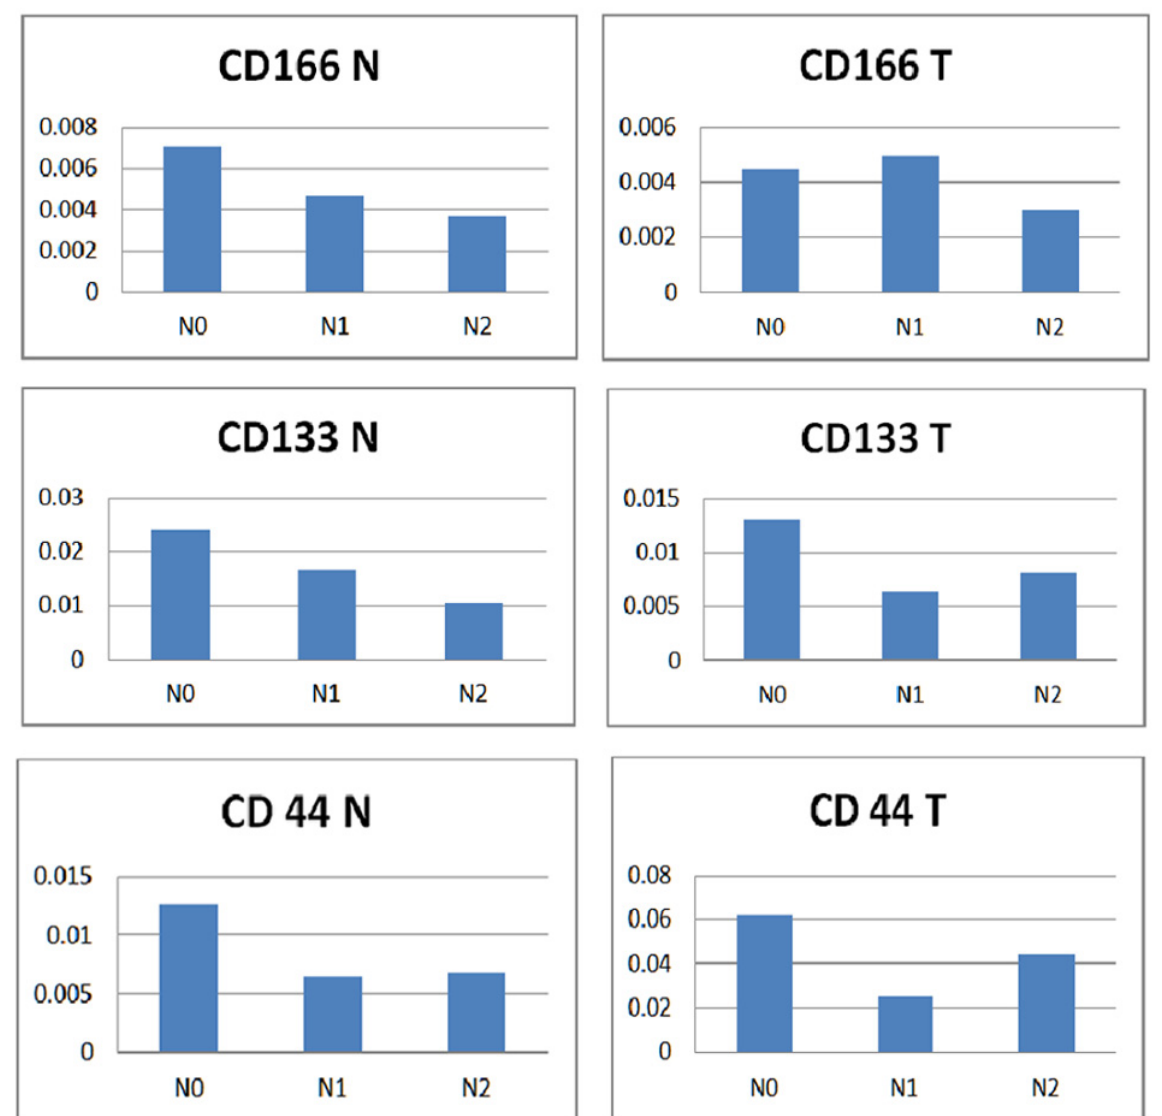
Figure 8. Normal versus tumor tissue expression of the three markers according to N staging. A non-parametric Kruskal–Wallis test was used to compare individual groups, and all values achieved statistical significance ( p < 0.05).